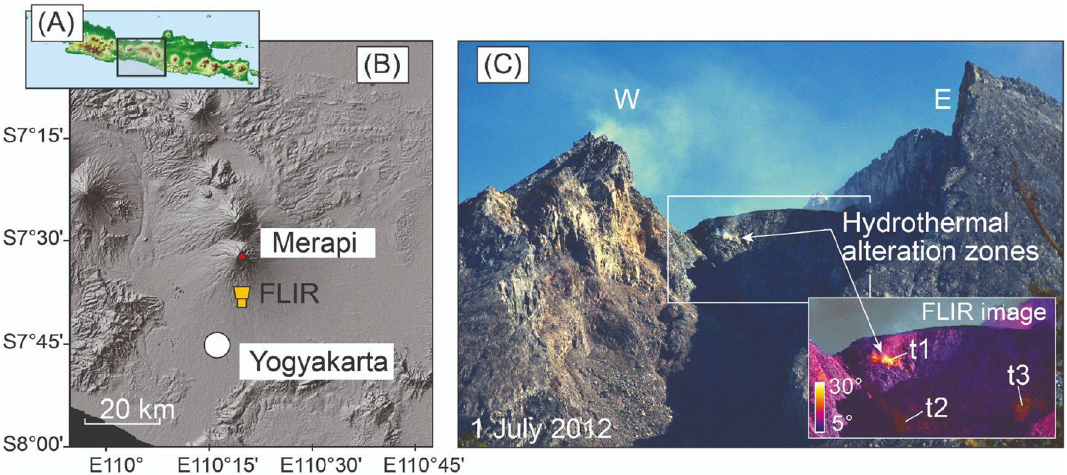
Figure 1. Merapi volcano. ( A ) Overview map of Java Island with Central Java marked by black box. ( B ) View of Merapi volcano from the South. White box marks enlarged area in subsequent image. ( C ) Merapi summit dome close up photograph showing fumarole activity and ongoing hydrothermal degassing including yellowish coloured alteration zones (1 July 2012). Inset in ( C ) shows a thermal infrared camera image (handheld camera type: FLIR P 660) that highlights apparent temperature highs located at the southern part of the lava dome (t1 and t2) prior to the 2012–2014 explosions. Mapviews were created using ArcMap (v10.5, https:// deskt op. arcgis. com/ de/ arcmap/), FLIR image created using the FLIR ThermaCAM Researcher Pro (vs2.10)